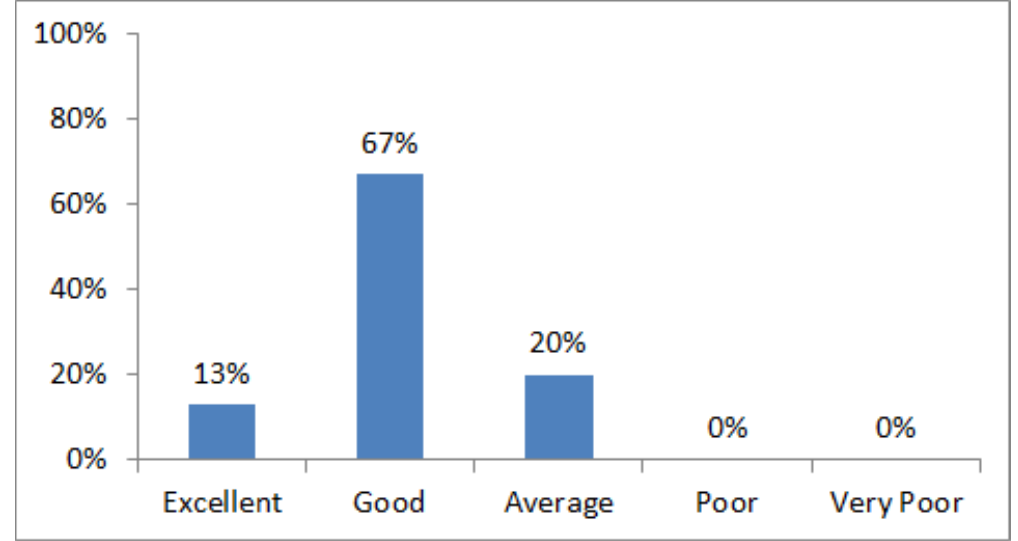
Figure 8. Alignment of services provided by the ICT area with the requirements of the